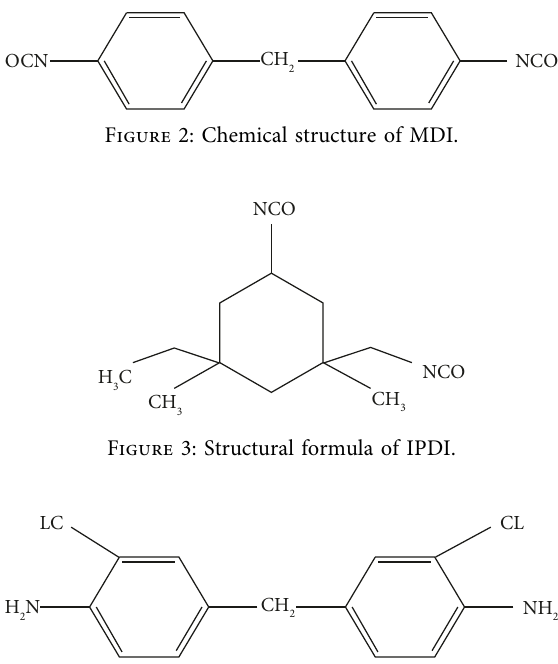
Figure 4: Structural formula of